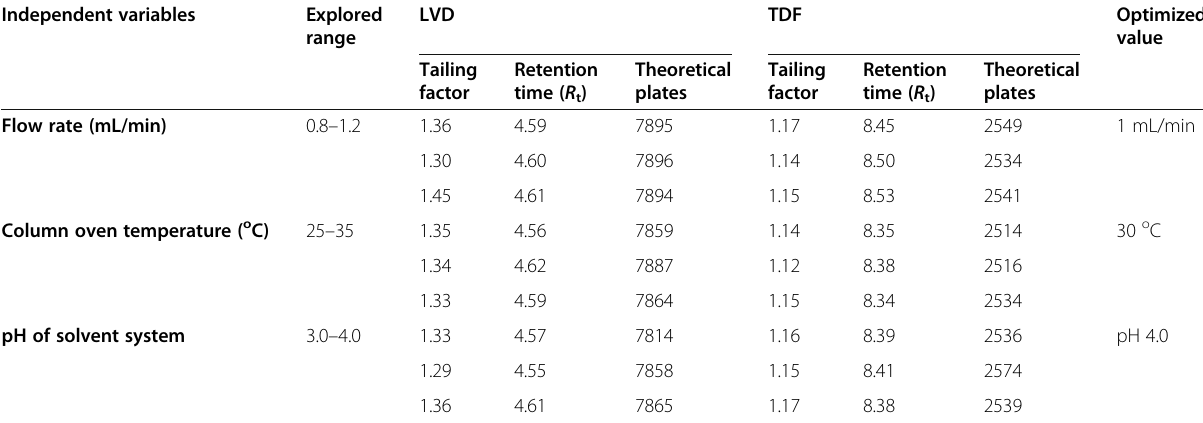
Table 4 Robustness evaluation Independent variables